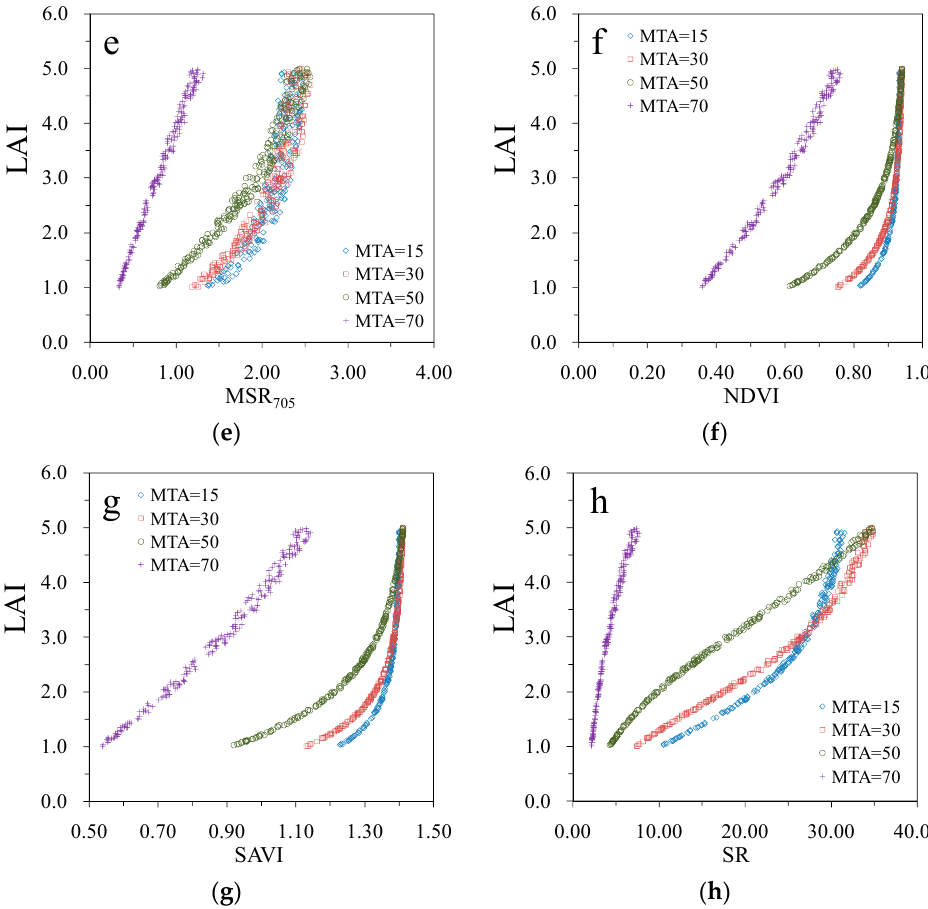
Figure 7. Correlation between vegetation indices and the leaf area index (LAI) for a fixed Cab (45–50 µg cm − 2 ) and different leaf mean tilt angles (MTA = 15, 30, 50, 70°): ( a ) BNDVI, ( b ) GARI, ( c ) GNDVI,